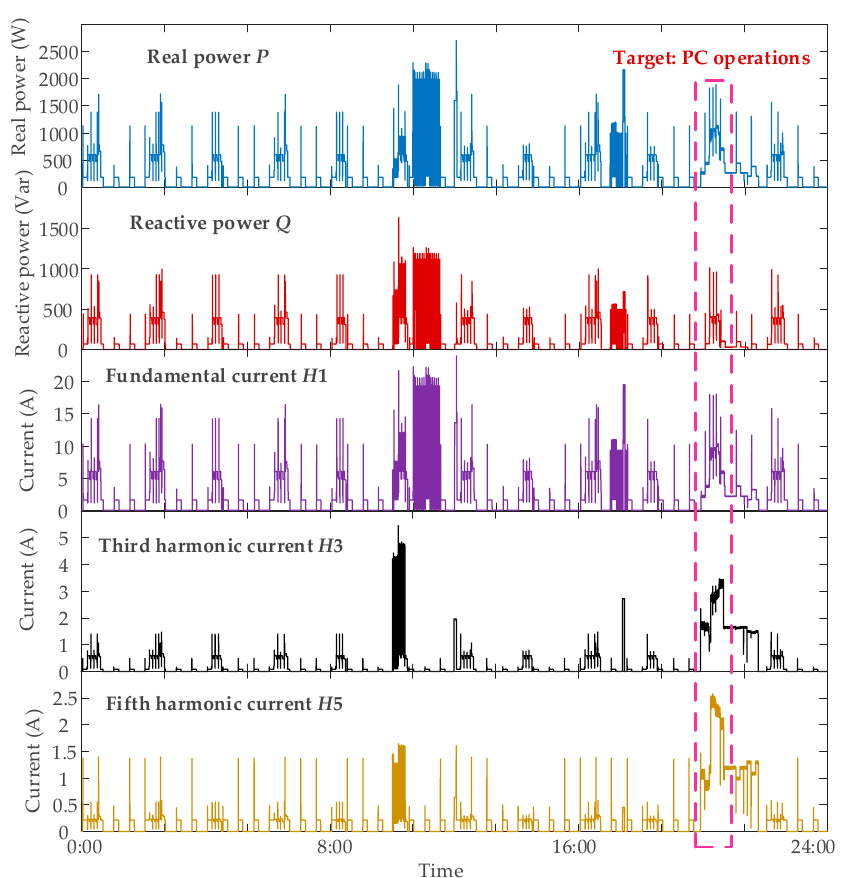
Figure 4. Detailed signal profiles of the measured data from phase A for certain day. Table 5. Two special scenarios for the PC related load